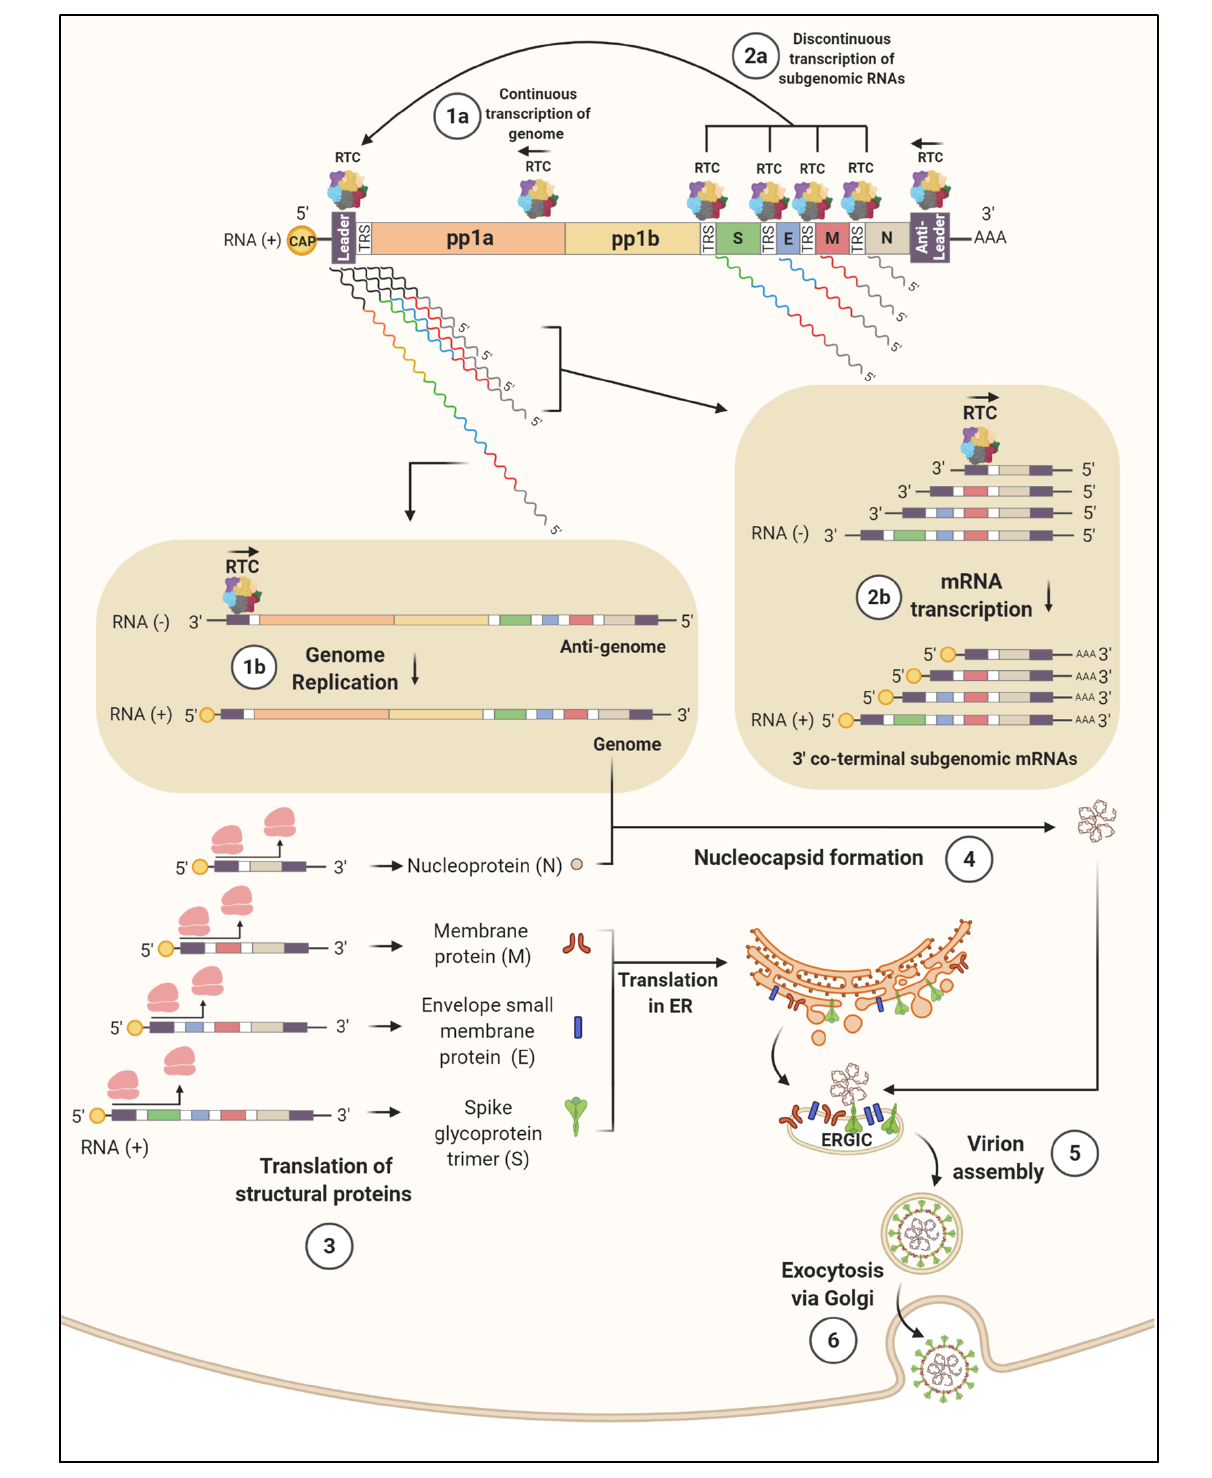
Figure 2 – Molecular events related to the expression of structural proteins, replication of the genome, and assembly of the SARS-CoV-2. Processes 1a and 1b: the synthesis of RNA (-) by RTC, initiated in the 3’ anti-leader sequence of the genome (+), may occur continuously, generating a complete copy of the genome called antigenome (-). The antigenome is then used by RTC to produce multiple copies of the genome (+). Processes 2a and 2b: RNA synthesis by RTC may, however, be temporarily interrupted when a TRS is copied. The newly synthesized RNA (-) is then transferred to the 5’ end of the genome, where the complementarity of sequences allows the RNA (-) synthesis to continue in the leader TRS, merging the sequences between body and leader TRSs. In turn, these subgenomic chimeric RNAs (-) serve as templates for the continuous synthesis of subgenomic mRNAs (+). Process 3: the structural S, E, M, and N proteins are then translated from the 3’-co-lateral subgenomic mRNAs (+), where S, E, and M proteins are produced in the rough endoplasmic reticulum. Process 4: the N protein produced in the cytosol interacts with the viral genome (+), forming the nucleocapsid. Process 5: membrane proteins S, M, and E then interact with viral nucleocapsids to form virions in the ERGIC. Process 6: finally, the virions are externalized from the cell by exocytosis via the Golgi pathway. TRS: Transcriptional Regulatory Sequences; ER: endoplasmic reticulum; RTC: Replication Transcription Complex. ERGIC: Endoplasmic Reticulum - Golgi Intermediate